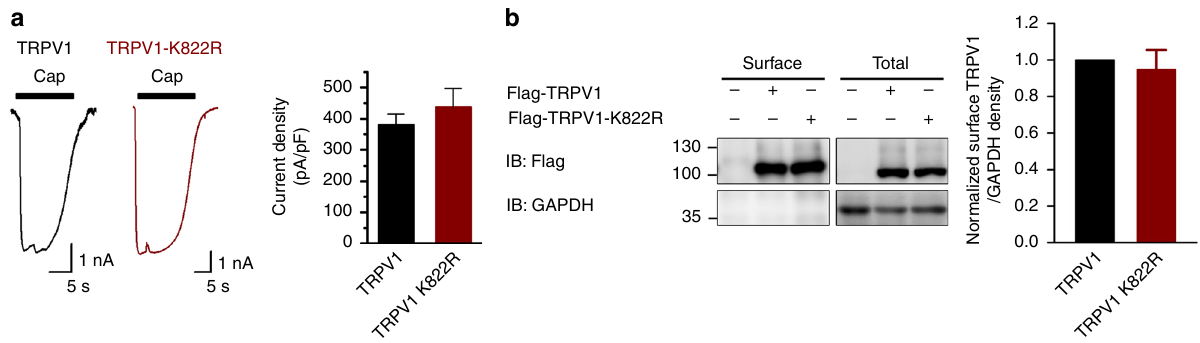
Fig. 5 K822R mutation of TRPV1 did not alter its membrane surface expression and capsaicin-evoked whole-cell current density. a CHO-K1 cells were transfected with Flag-TRPV1 or Flag-TRPV1-K822R. Representative traces (left) and summary of current density (right) for capsaicin (1 μ M)-activated whole-cell currents at − 60 mV are shown. The current densities are: TRPV1, 345 ± 56 pA/pF ( n = 7) and TRPV1-K822R, 398 ± 59 pA/pF ( n = 5). Data are means ± s.e.m. b CHO-K1 cells were transfected with Flag-TRPV1 or Flag-TRPV1-K822R. Surface levels of TRPV1 were measured by IB after plasma membrane proteins were biotinylated and puri fi ed with streptavidin-agarose. GAPDH were used as controls for cytoplasmic proteins, respectively. Blots are representatives of at least three independent